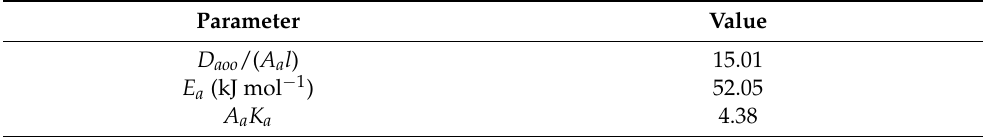
Table 2. Parameter values for equation